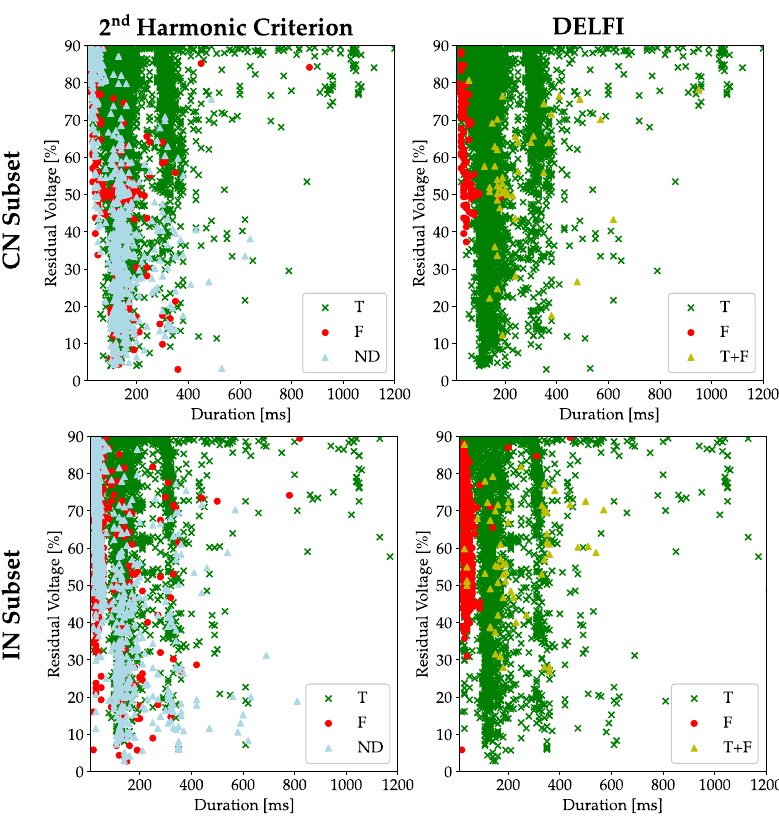
Figure 19. Scatter plot in the duration–residual voltage plane for each class and subset (CN and IN) of the respective classifiers.